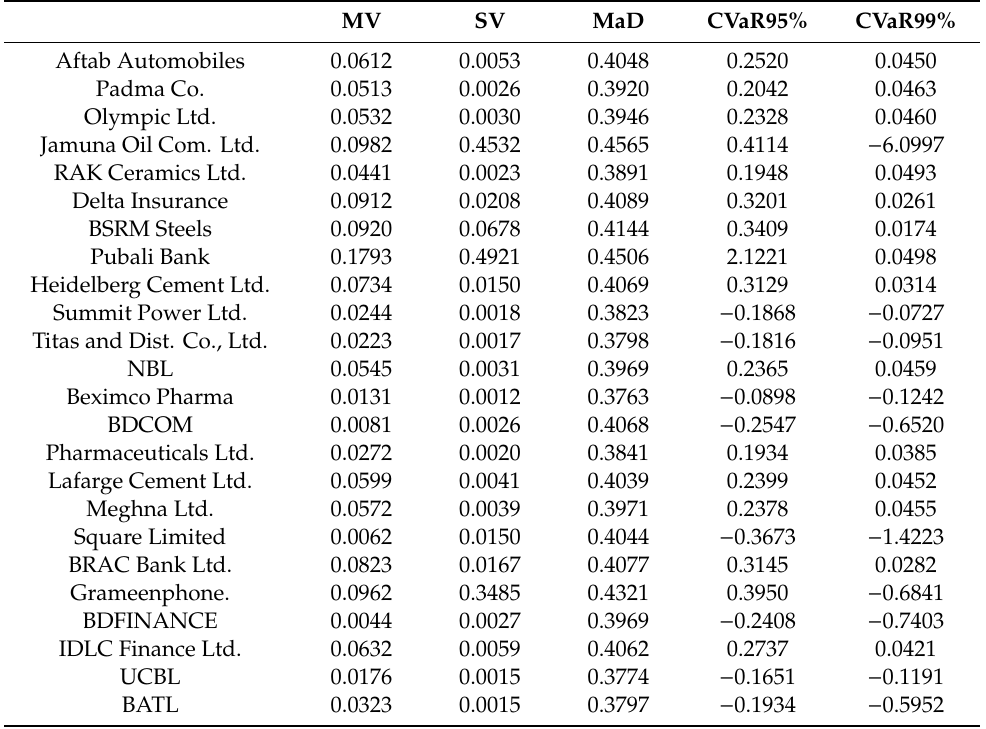
Table 6. Optimal portfolio compositions for economic growth period